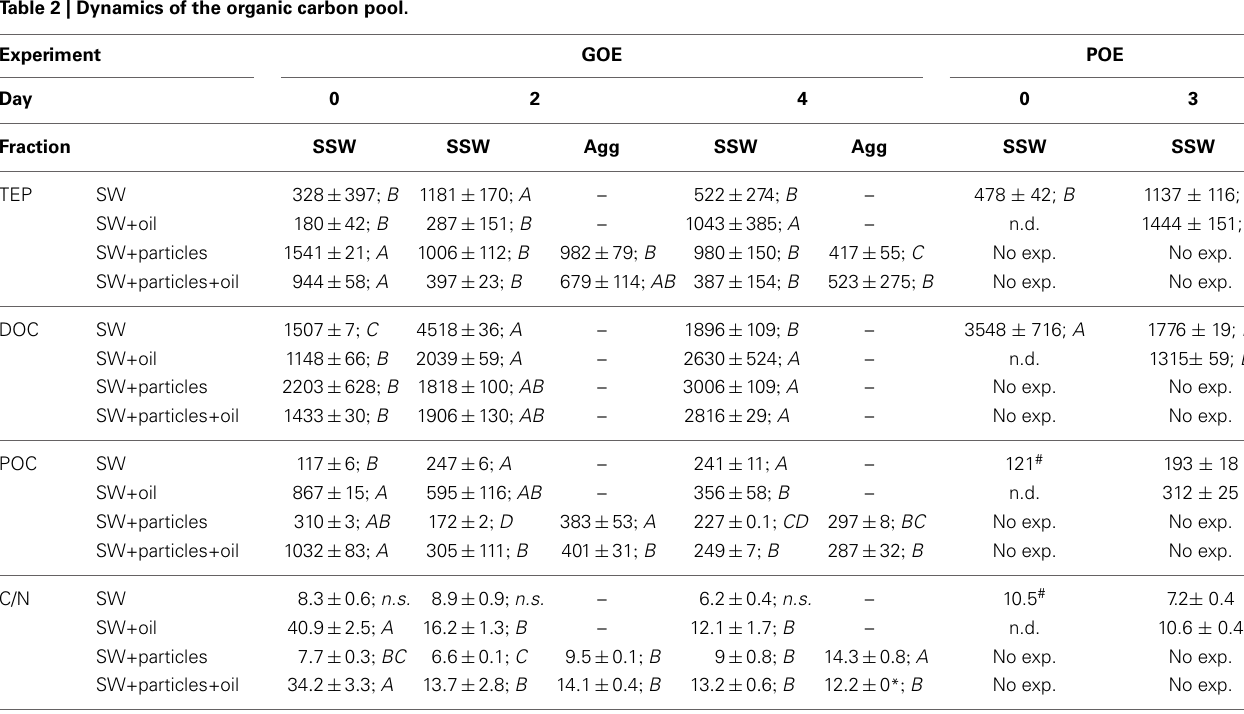
Table 2 | Dynamics of the organic carbon pool.